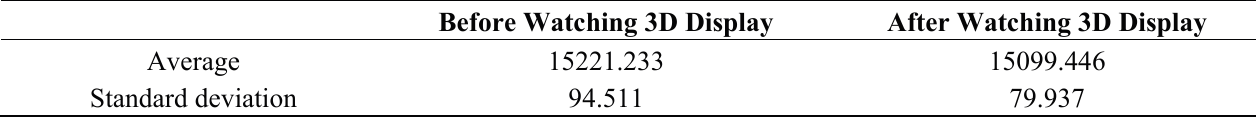
Table 6. The average and standard deviation of